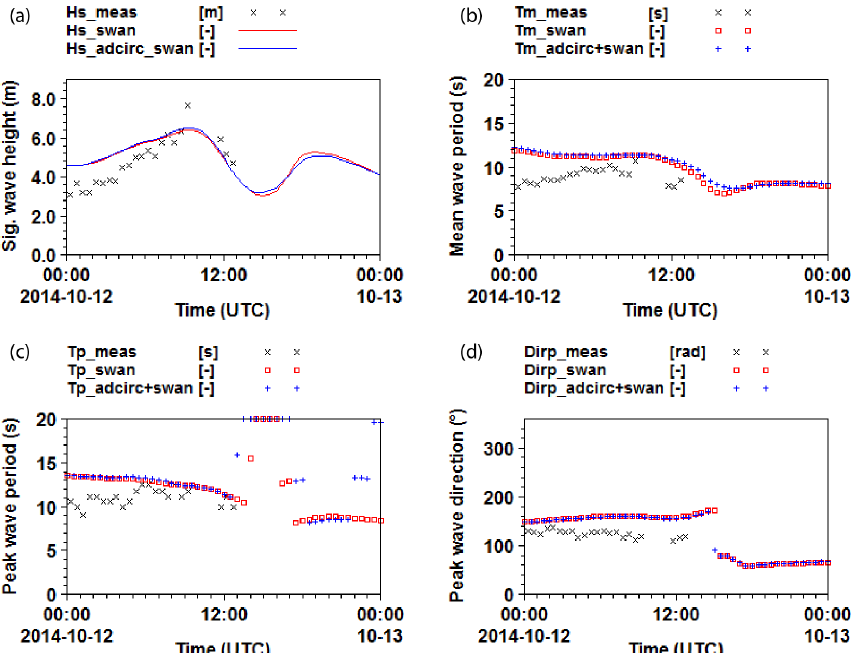
Figure 8. Comparison of measured (black) and modelled (a) significant wave heights ( H s ) , (b) mean wave periods, (c) peak wave periods and (d) peak wave directions obtained from SWAN (red) and coupled ADCIRC + SWAN (blue) during Hudhud cyclone with measured data off Visakhapatnam (17.63 ◦ N, 83.26 ◦